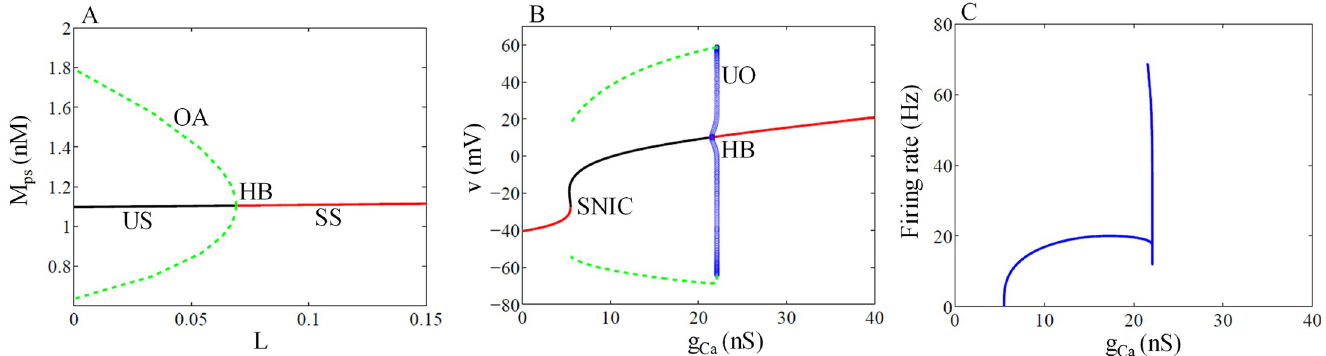
Fig 2. Bifurcation diagram for Goodwin and ML model. (A) Codimension-1 bifurcation diagram of GRN with L as the bifurcation parameter. At lower values of L, the system shows sustained oscillation. Broken green lines are the amplitude of the oscillation (OA), and black lines are the unstable steady state (US). As light intensity increases, sustained oscillation disappears via supercritical Hopf bifurcation (HB), and the system enters the stable steady state (red lines, SS). (B) Codimension-1 bifurcation diagram of modified ML model with g Ca as bifurcation parameter. For lower values of g Ca , the system is in stable steady states (red line). As g Ca increases stable steady state and unstable steady state merge each other and oscillations arise via SNIC bifurcation. Stable oscillations disappeared via subcritical Hopf bifurcation (HB) at g Ca = 21.5 nS . Blue circles are unstable oscillation amplitude (UO). (C) Firing rate as a function of g Ca . When g Ca = 5.49 nS , ML model starts firing with a = 6.35 nS , its firing rate increased to 10 Hz, and when g > 6.35 nS , firing rate become greater than 10Hz. Here we take frequency less than 0.5 Hz, when g Ca Ca ¼ g , the rest of the parameter values are the same as described in materials and method section. Xppaut [81] was used for simulating the bifurcation g Ca Ca base